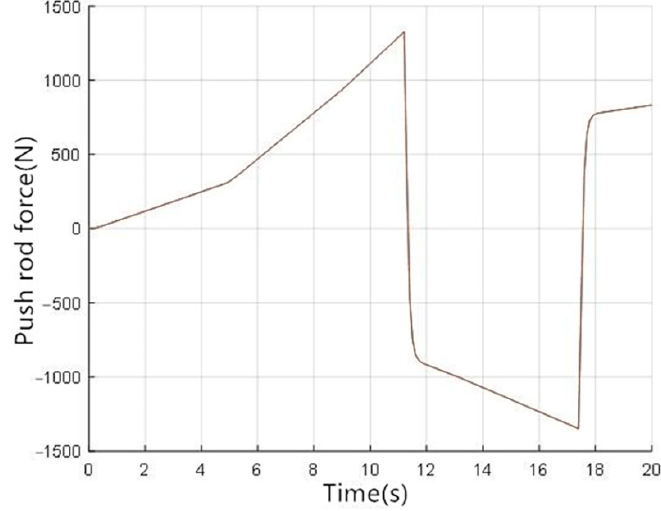
Figure 14. Push rod force curve of PBC.